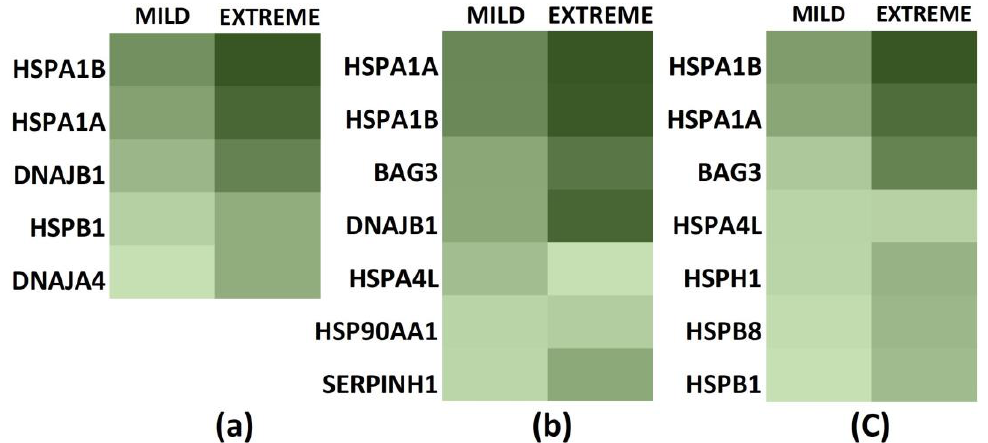
Figure 6. Heat maps showing relative gene expression profiles of stress responses during mild and extreme heat-stress exposure. ( a ) Daoy, ( b ) SH-SY5Y, and ( c ) differentiated SH-SY5Y cells. Comparisons were made for genes significantly expressed during mild heat stress.